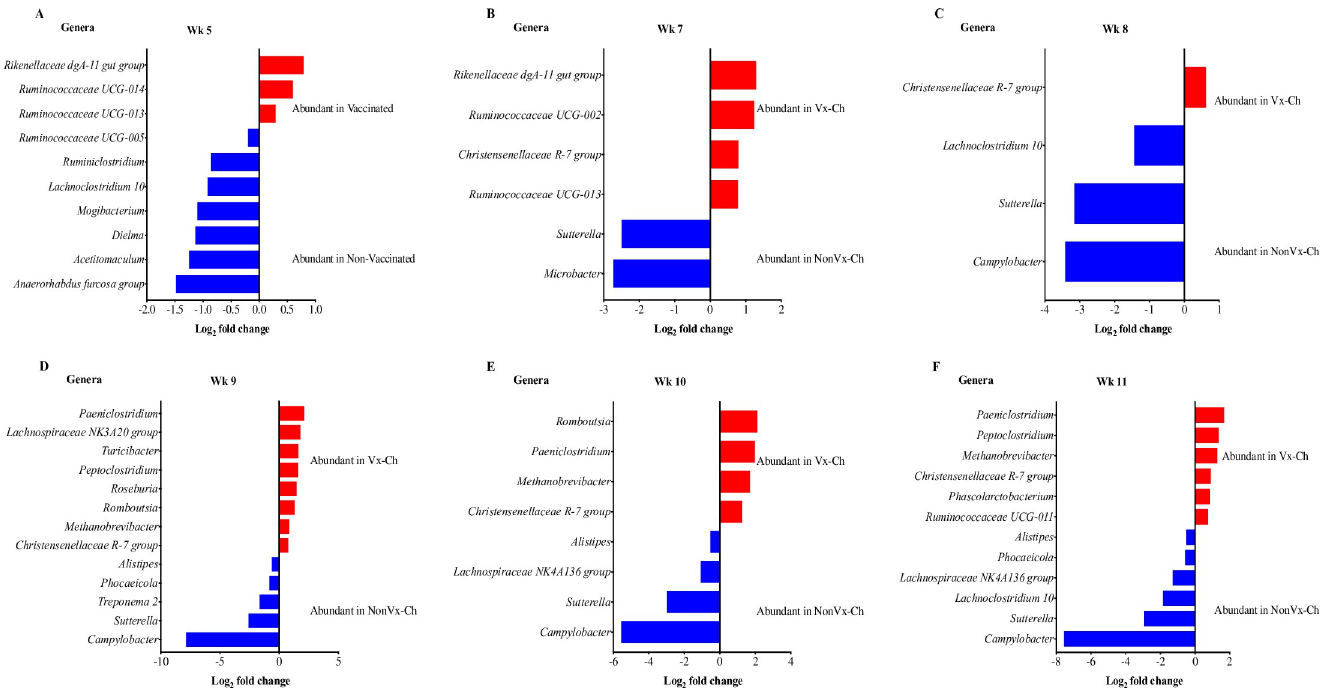
Fig 4. Differential abundance analysis (DAA) of OTUs (genus-level) between (A) all vaccinated and non-vaccinated calves at week 5, and (B-F) all vaccinated and challenged (Vx-Ch), and non-vaccinated and challenged (NonVx-Ch) groups at weeks 7, 8, 9, 10 and 11. The red and blue bars represent genera that are relatively more abundant in the respective group as shown on the